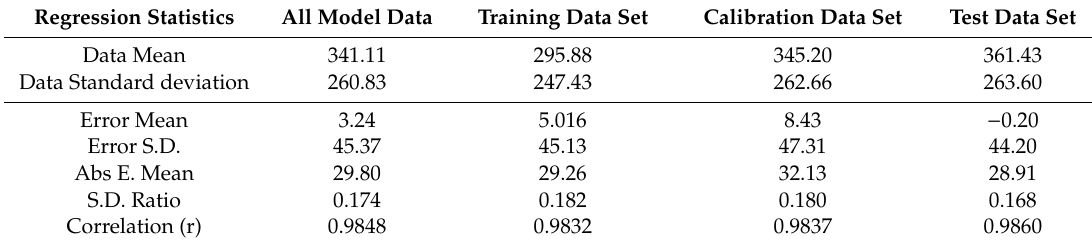
Figure 5. Correlation between the observed and simulated chloride concentration using the ANN model; ( a ) for the whole data set and ( b ) for the data set of October 2000. Table 3. The values of the performance of indicators for the ANN model’s